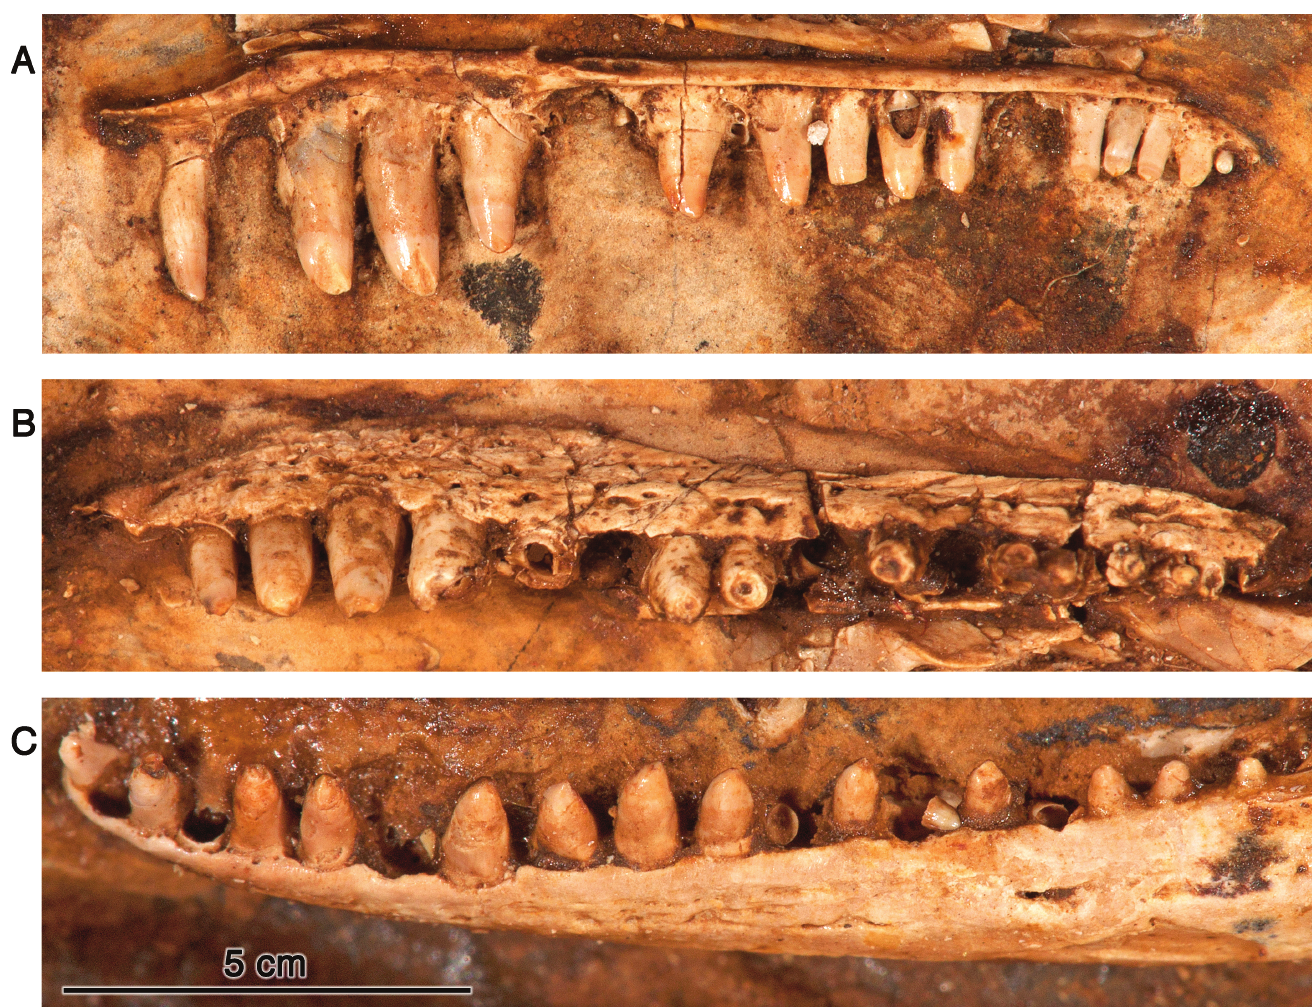
Figure 3. Marginal dentition of Euconcordia cunninghami . A, KUVP 96164a, right premaxilla and maxilla exposed in lingual view. B, KUVP 96164a, left maxilla exposed in partial lateroventral view. C, KUVP 87102a, dentition on left dentary, exposed in partial lateral view. Scale bar =